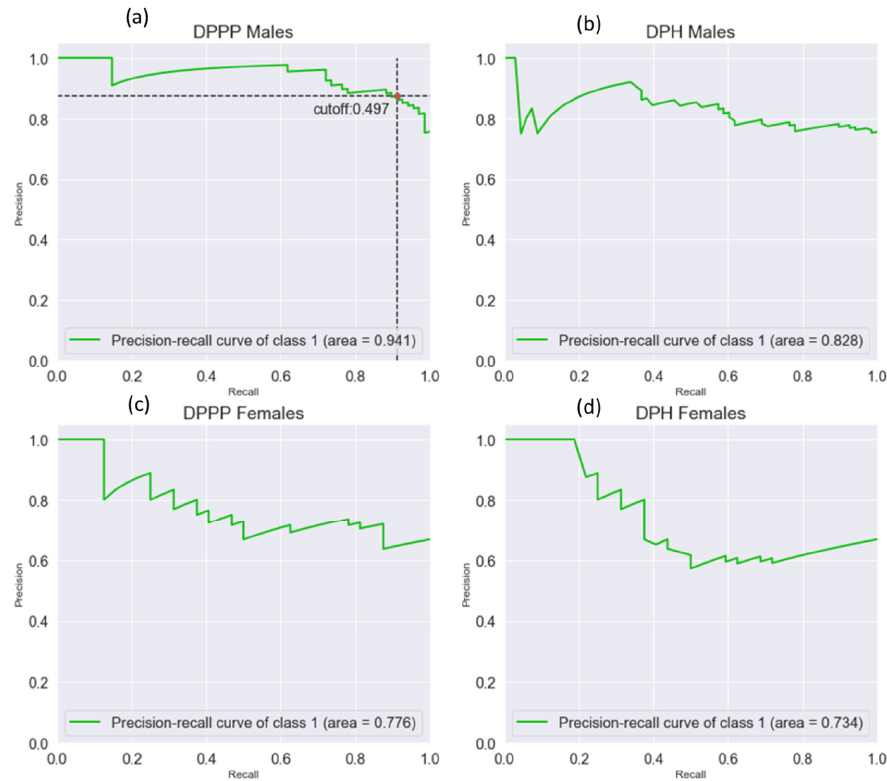
Figure 5. Precision–recall analysis. The four PR curves present the precision–recall analysis. In the insets, the values of the area under the curves are reported. In the DPPP males curve ( a ), the cut-o ff value of 0.497 is indicated. The precision–recall curve ( a ) highlights that erythrocyte lipid hydroperoxides, measured by DPPP, in men may suggest this parameter as a biomarker to predict CVD in men. The precision–recall curve for DPPP classifier in females ( b ), for DPH classifier in males ( c ), and for DPH classifier in females ( d